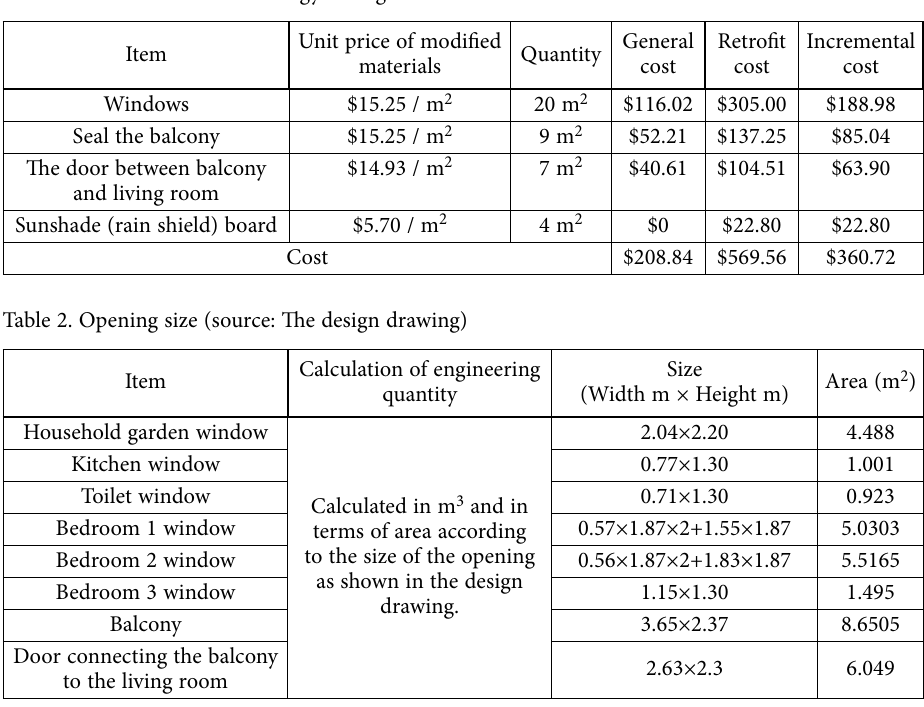
Table 1. Incremental cost of energy-saving retrofits